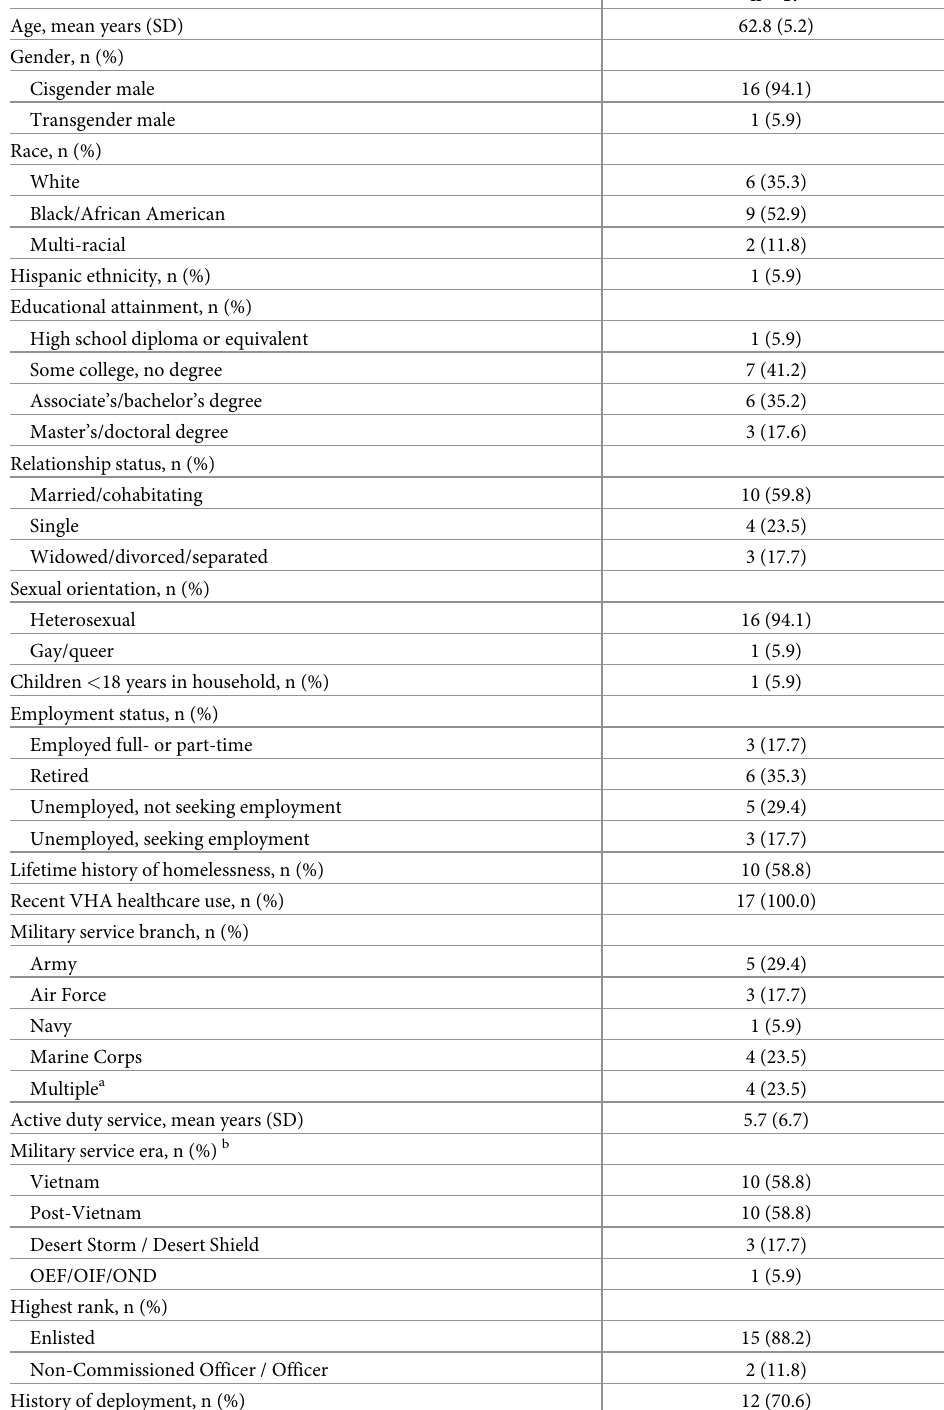
Table 1. Sociodemographic and military service